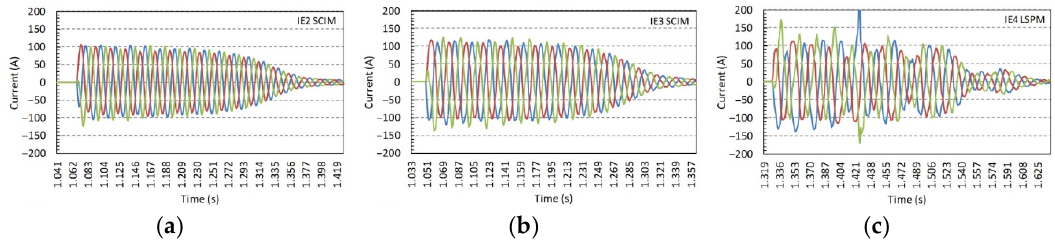
Figure 2. Line currents during starting for [62] ( a ) IE2 squirrel cage induction motor (SCIM); ( b ) IE3 SCIM; ( c ) IE4 LSPMM.